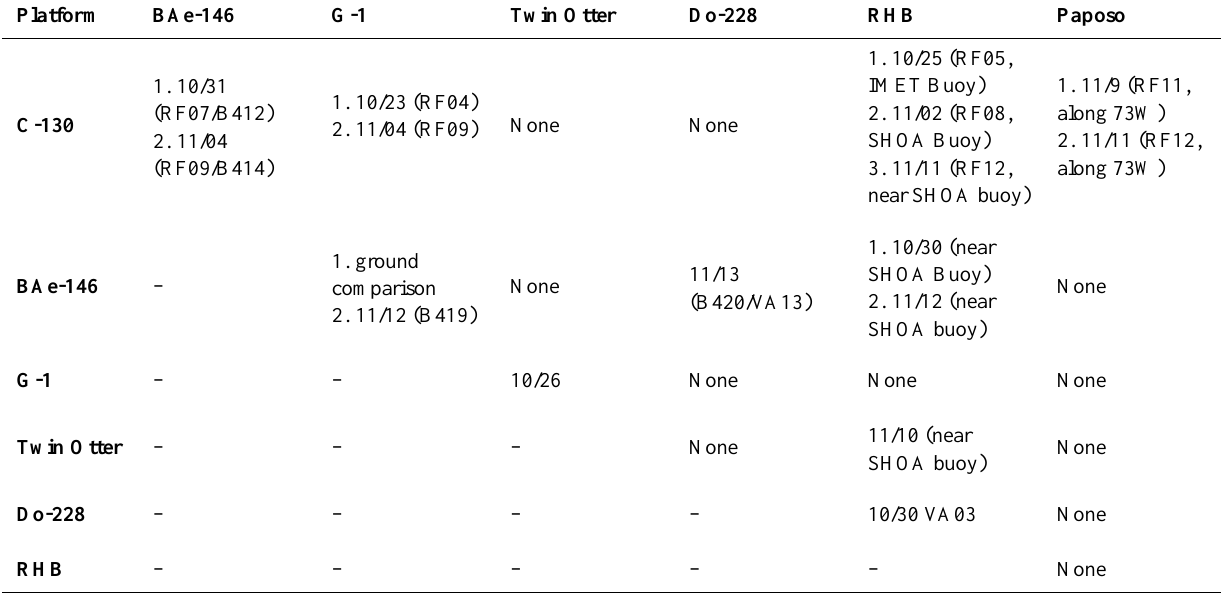
Table 12. Details of the intercomparisons conducted VOCALS-REx.